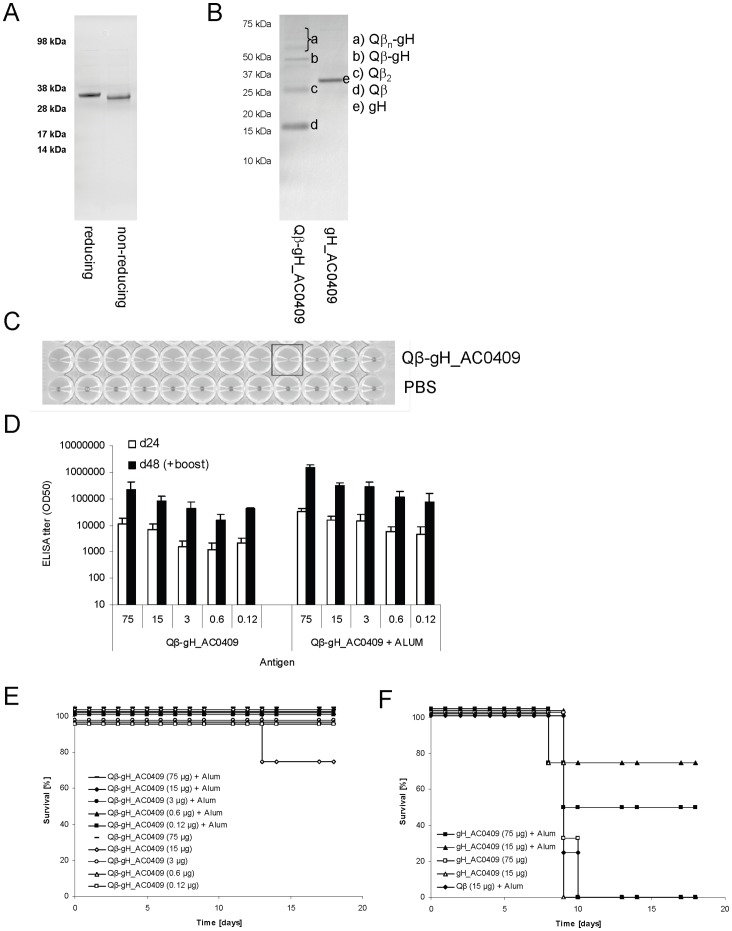
Evaluation of the Qβ -gH vaccine technology for currently circulating H1N1 strain namely influenza A/California/04/09 virus.
A gH_AC0409 protein after purification and refolding was analyzed on a reducing or non-reducing denaturing Commassie stained SDS-PAGE gel. A shift of the bands between the two lanes can be seen. 4 µg of total protein were loaded in one lane. B Qβ -gH_AC0409 conjugate vaccine was analyzed on a reducing denaturing Commassie stained SDS-PAGE gel. 4 µg of total protein were loaded in one lane. C Assessment of the quality of Qβ -gH_AC0709 conjugate vaccine in a Hemagglutination assay. 5.5 pg of the vaccine were enough to agglutinate chicken red blood cells. D Groups of six-weeks old female BALB/c mice (n = 4) were immunized subcutaneously twice with titrating amounts of Qβ -gH_AC0409 vaccine with or without ALUM (90 µg of ALUM/mouse). IgG antibody titers specific for native HA protein of A/California/04/09 were measured at day 24 and day 48 after immunization. ELISA titers are indicated as IgG titer at which half-maximal OD was reached (OD50). E, F Twenty days after second immunization mice were infected i.n. with a lethal dose (4× LD50) of m.a. influenza A/PR/8/34 and survival of individual mice was monitored for 18 days.